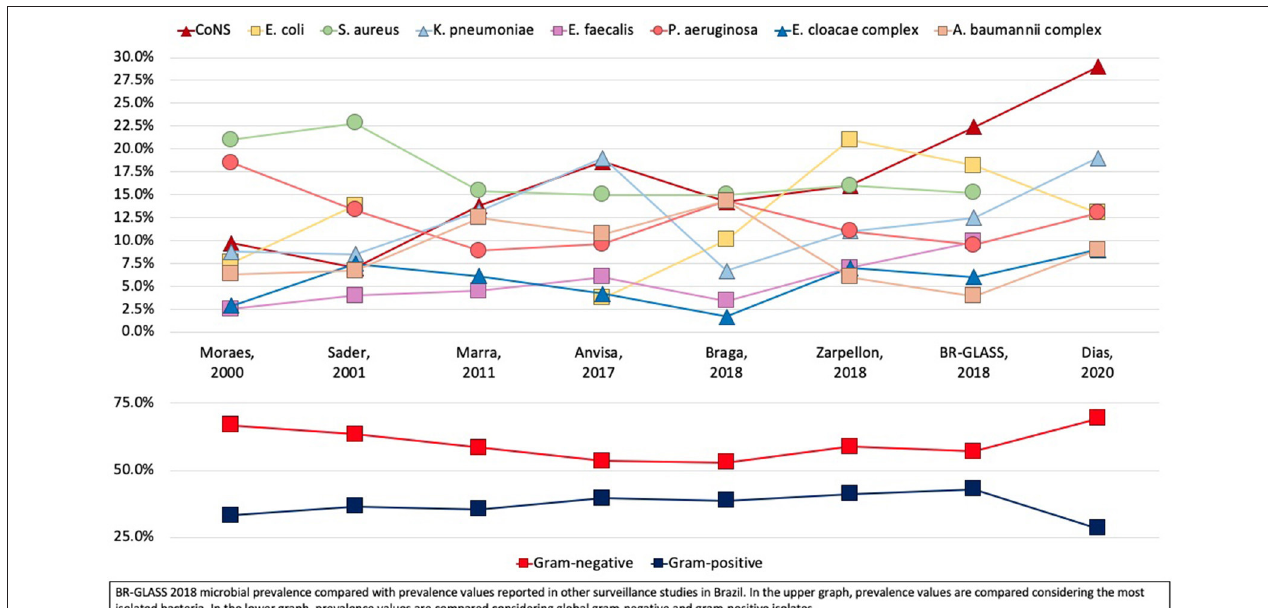
FIGURE 7 | BR-GLASS 2018 microbial prevalence compared with prevalence values reported in other surveillance studies in Brazil.